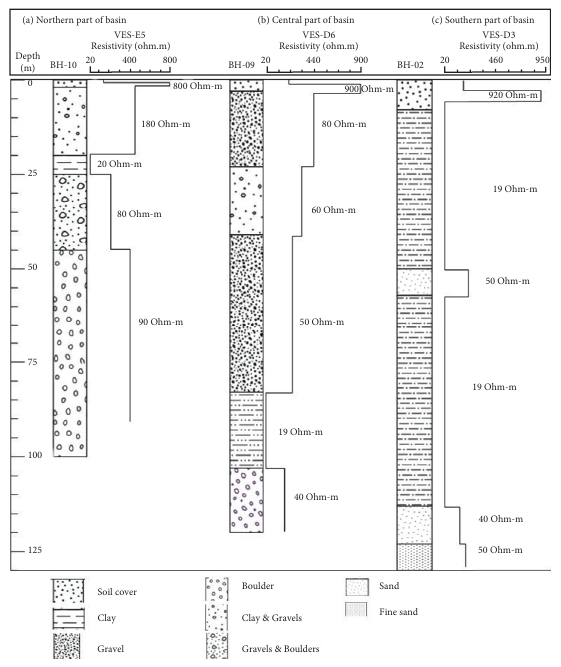
Figure 6: (a – c) VES curves (E5, D6, and D3) showing well- correlation with the lithological units, thicknesses, and depths, encountered in the boreholes (BH-10, BH-09, and BH-02) in the northern, central, and southern regions across the Haripur